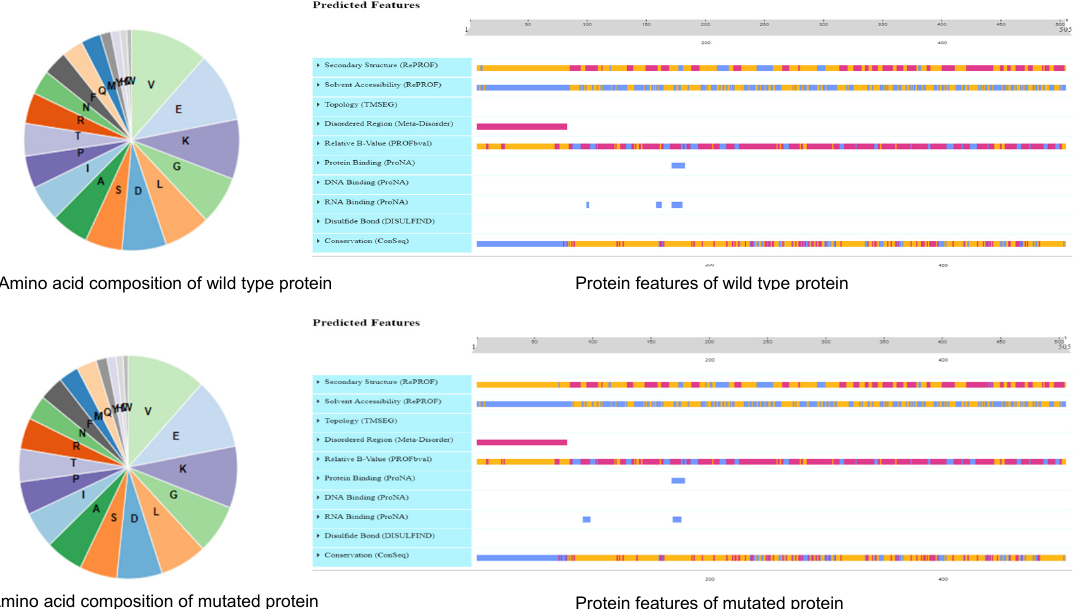
Figure 3. The protein structure (motifs) variants of Glyma.05G243400 between reference (WT) and mutated proteins using the PredictProtein software: https://predictprotein.org (accessed on 21 June 2022) .